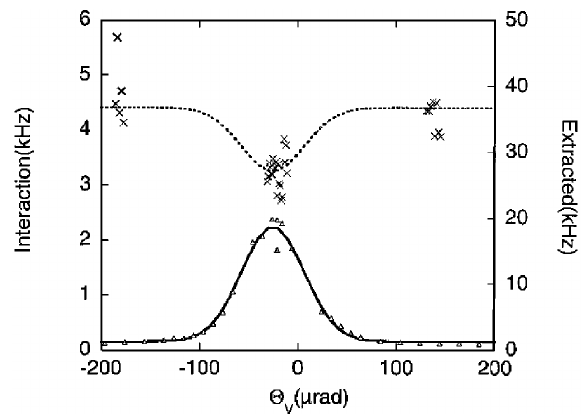
FIG. 3. The lower data set (right ordinate) is the counting rate in a coincidence between scintillators in the two air gaps as the vertical angle of the crystal was varied. The solid curve is a fit to a Gaussian plus a flat background. The upper data set (left ordinate) is the counting rate in the interaction monitor at three different vertical angles. The dotted curve is a Gaussian of the same width and central value as the solid